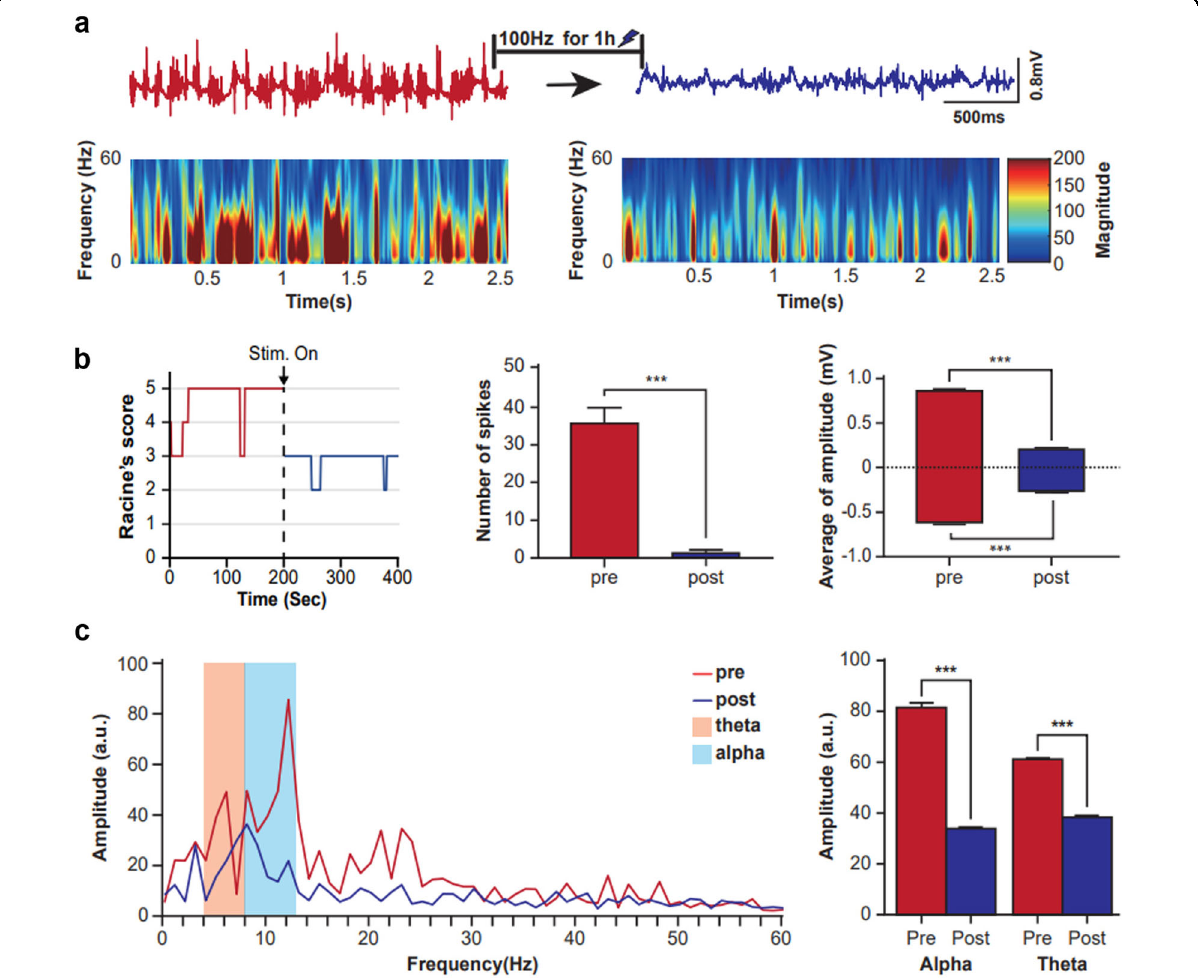
Fig. 5 Therapeutic effects of the hybrid graphene multichannel electrode on epileptic seizures. a Representative traces and spectrograms of generalized seizures (red, before sHFS) and suppression of epileptiform activities (blue, after sHFS). b Histograms show that cortical sHFS (200 μ A, 100 Hz, 1 h) reduced the behavioral severity and the number and amplitude of spikes in SE rats. c Fourier transformation prestimulation (red line) and poststimulation (blue line). Theta and alpha wavelengths are signi fi cantly reduced after cortical sHFS. Data are expressed as the mean ± standard error (SEM). *** p <